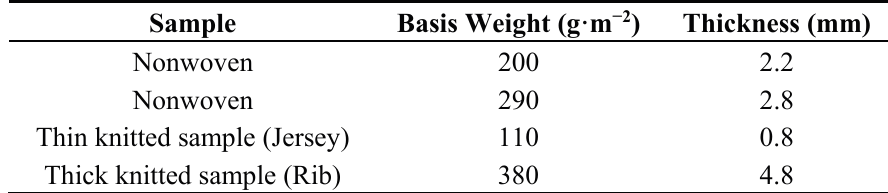
Table 2. Characteristics of the PP textile